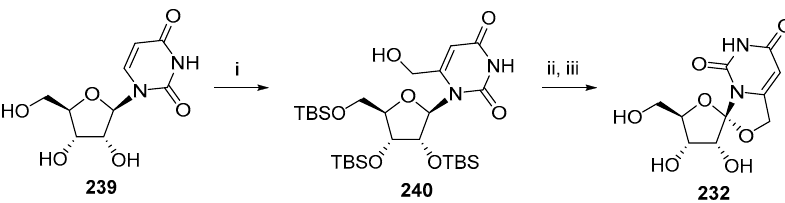
Molecules 2017 , 22 , 2028 28 of 35 Figure 10. Polycyclic spironucleosides. Scheme 45. Reagents and conditions: (i) Hg(OAc) 2 , ∆ ; (ii) iodomercuration, 75%; (iii) t -BuOK, DMSO, 60 °C, 60%. On the other hand, starting from psicofuranosyl nucleoside 237 , acetylation and bromination gave intermediate 238 , which on treatment with methanolic ammonia afforded the cyclonucleoside 239 (Scheme 46).